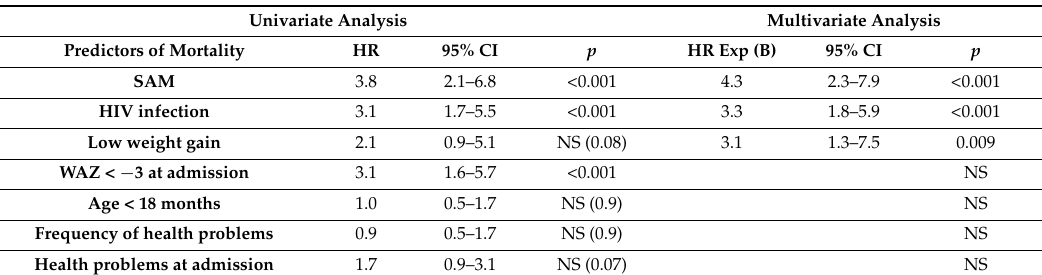
Table 4. Predictors of mortality. Cox proportional risk